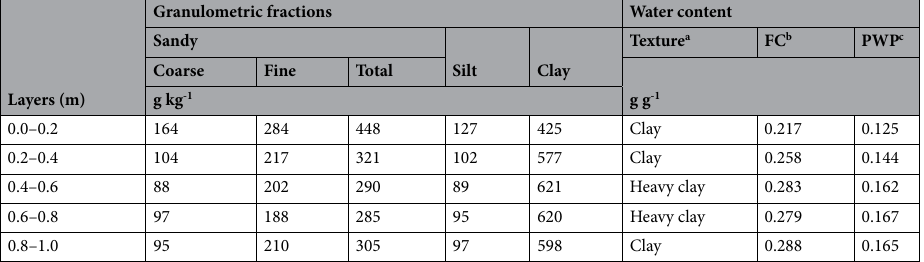
Table 1. Soil physical characteristics of the Rhodic Kandiudox. a Descriptions were derived from the particle size distributions according to the texture classification scheme of Brazilian Soil Taxonomy System 17 ; b water content in field capacity; c water content in permanent wilting